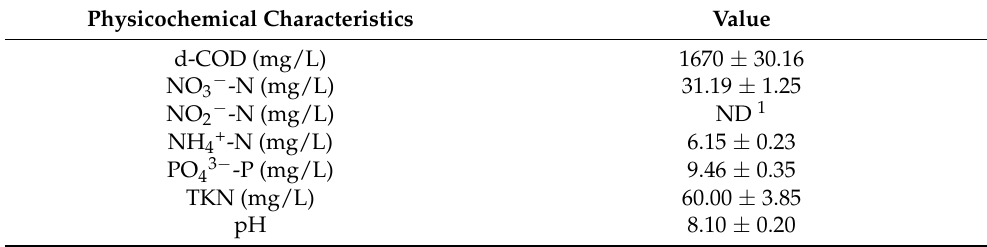
Table 1. Physicochemical characteristics of the brewery wastewater used in the experiments. Data are presented as mean ± SD values from three separate